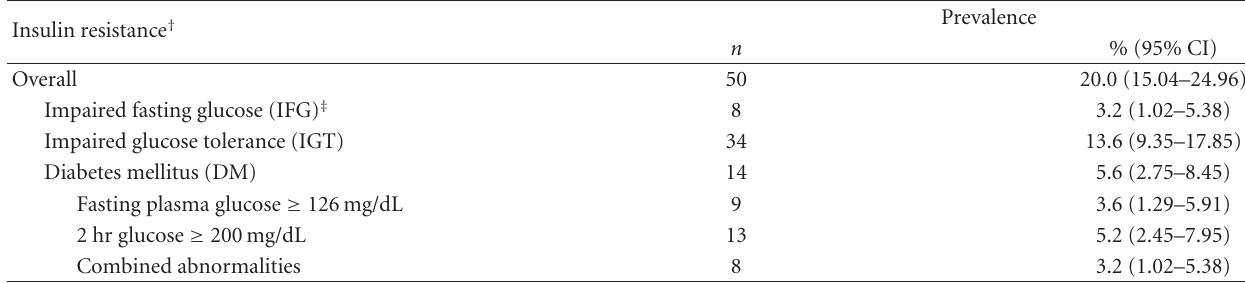
Table 2: Prevalence of insulin resistance in 250 Thai women with polycystic ovary